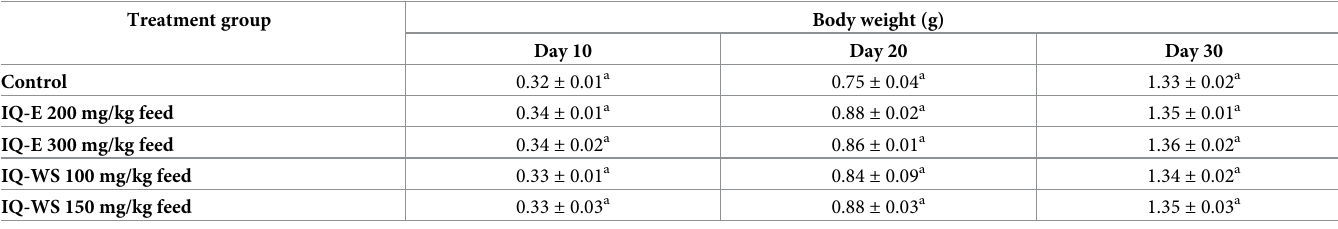
Table 3. Effects of IQ extracts on growth performance of the healthy shrimp. Treatment group